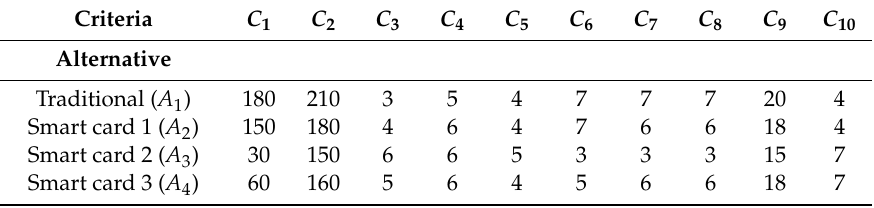
Table A5. Initial decision matrix filled by DM5 for WASPAS